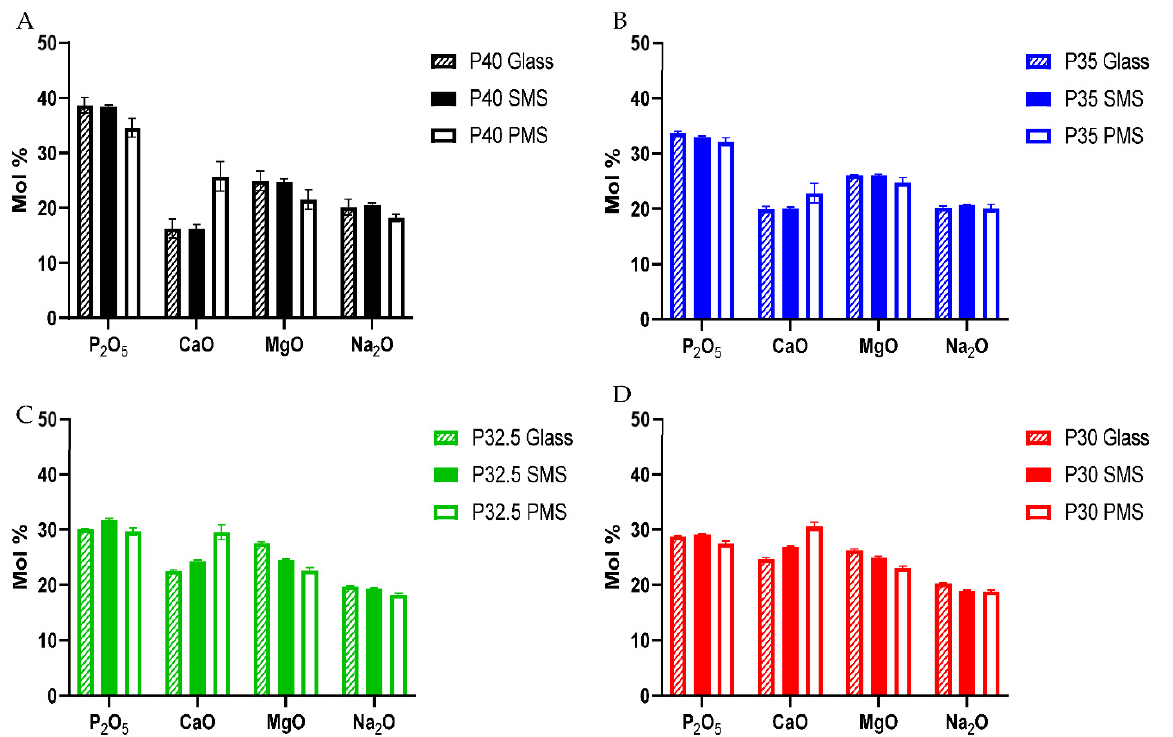
Figure 4. Chemical composition of the starting glass, solid and porous microspheres ascertained via EDX analysis. ( A ) P40, ( B ) P35, ( C ) P32.5 and ( D ) P30. EDX analysis. ( A ) P40, ( B ) P35, ( C ) P32.5 and ( D )